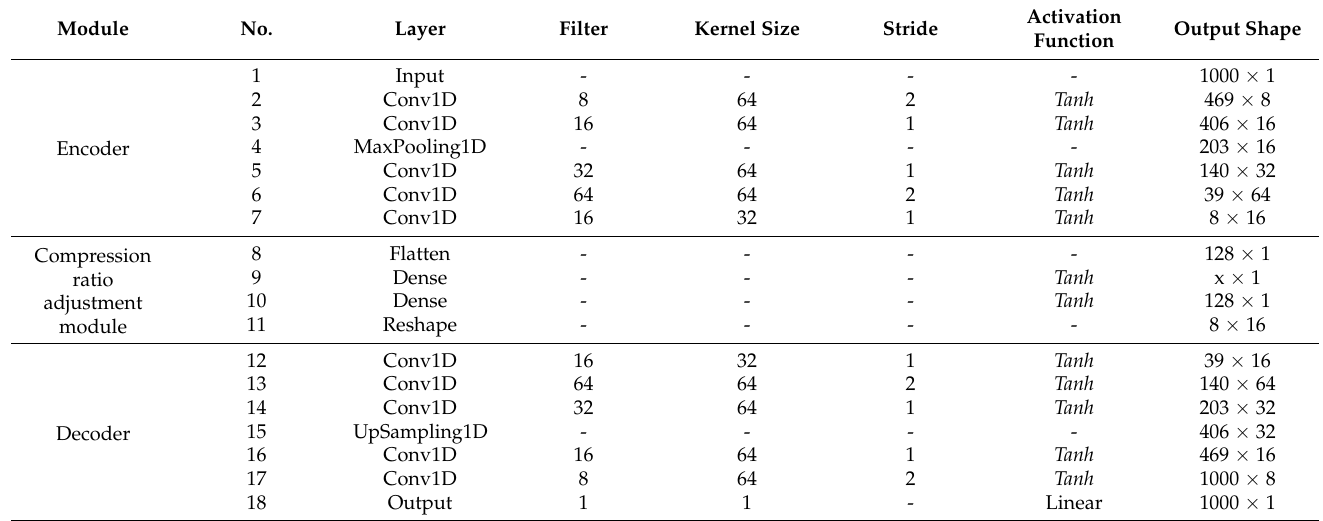
Table 1. Detailed parameters of LCSAE model